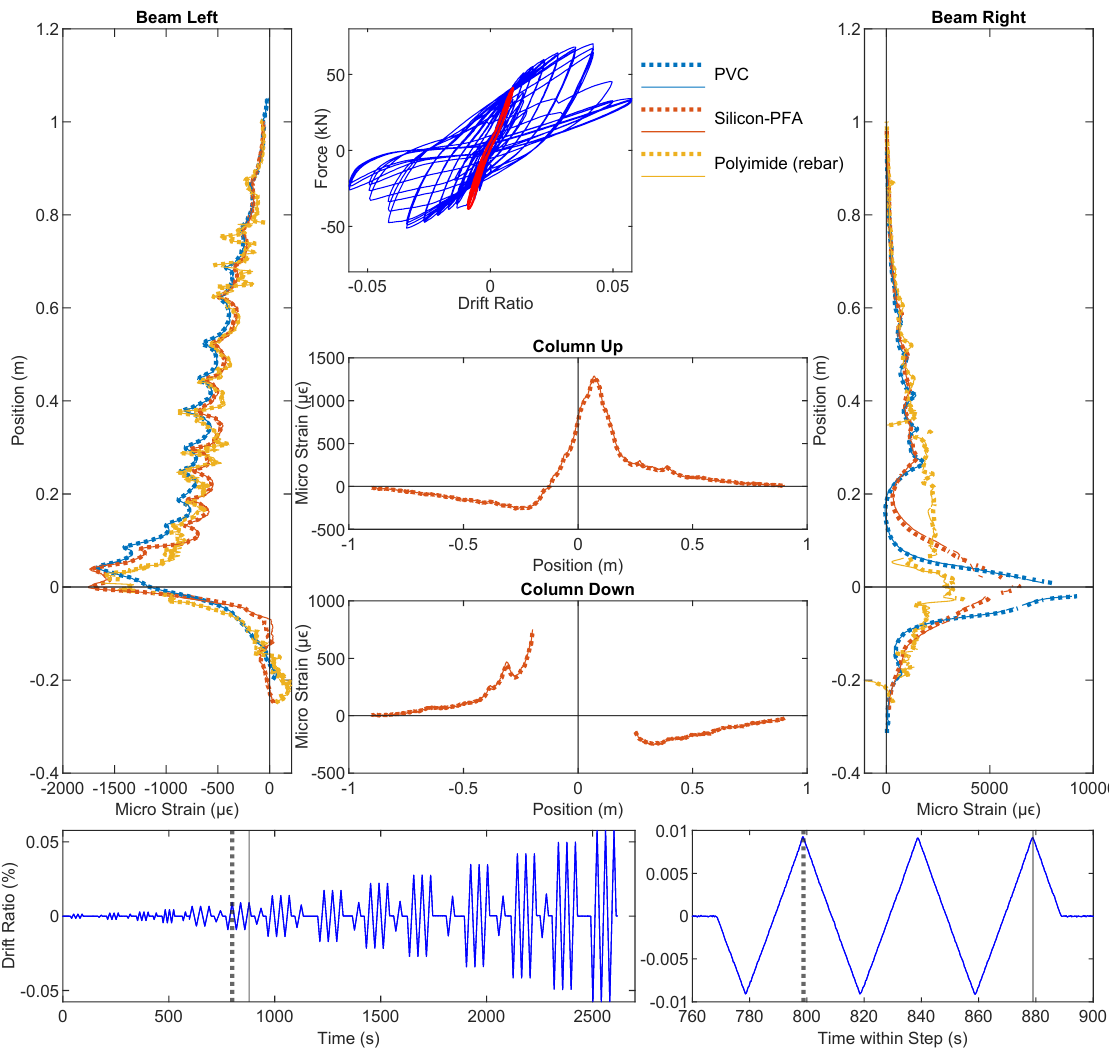
Figure 9. DFOS results at drift level